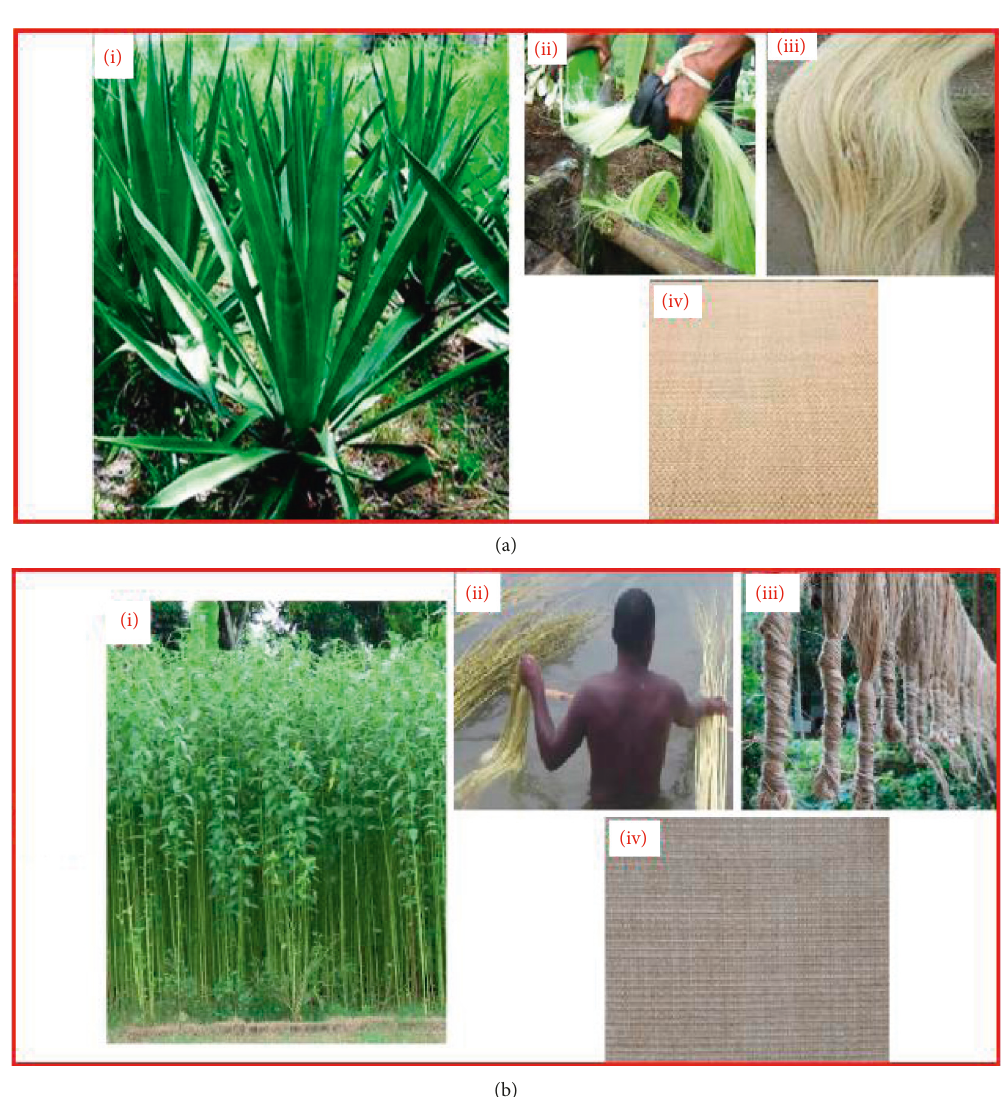
Figure 1: Fibre extractionprocess. (a) Extraction ofsisal fibre,(i)sisalplant, (ii) fibre extractionprocess, (iii)a bundleoffibre, and (vi) fibremat used in the study. (b) Extraction of Jute fibre, (i) jute plant, (ii) fibre extraction process, (iii) a bundle of fibre, and (vi) fibre mat used in the study.